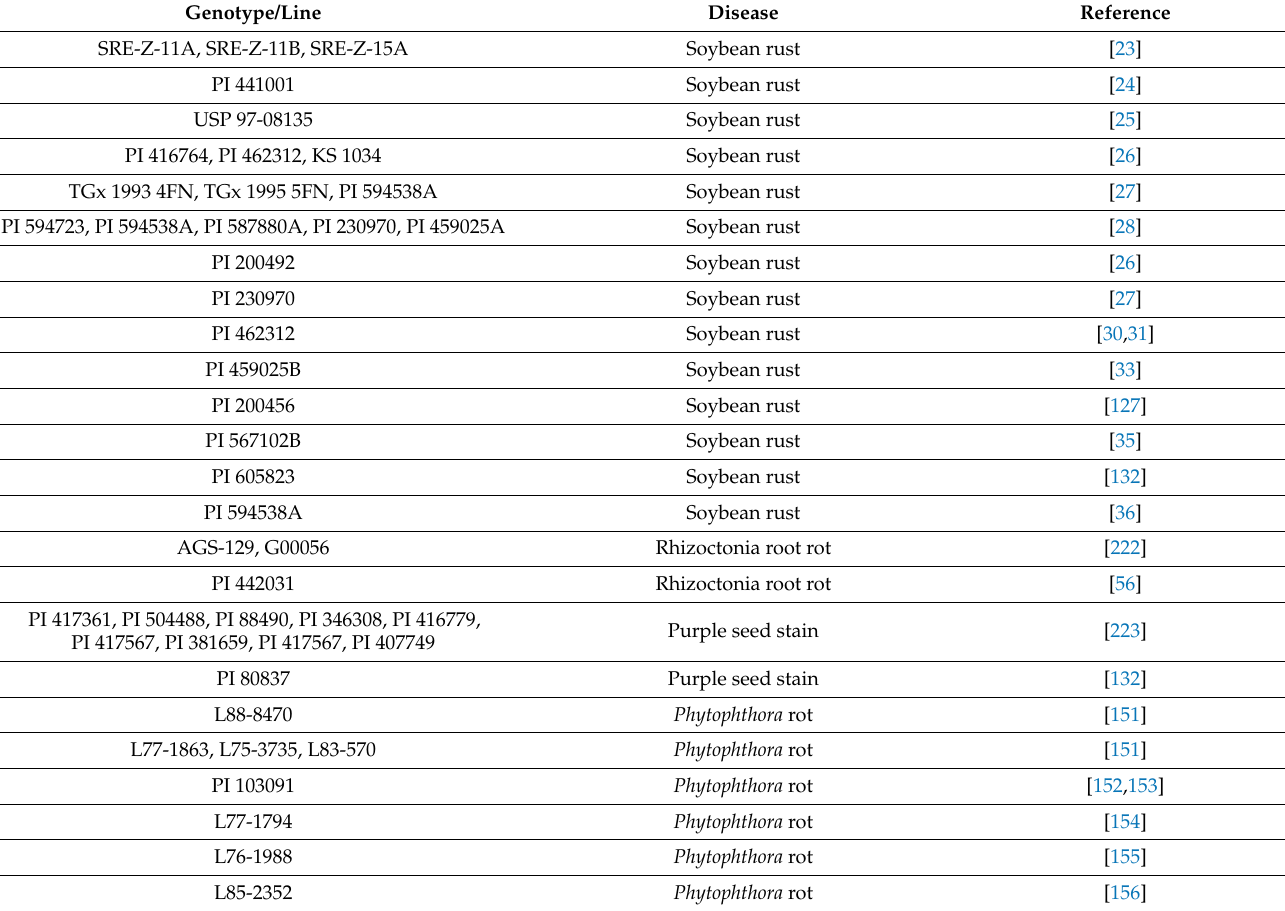
Table 2. List of identified/developed soybean genotypes/lines with resistance against various diseases.